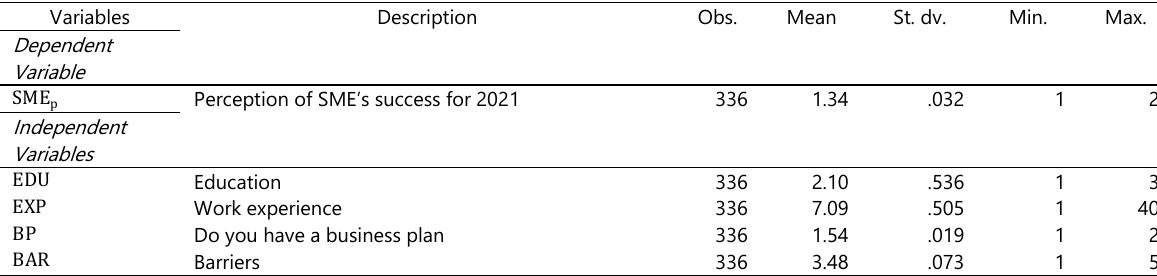
Table 1: Variable and Statistics Description (Source: Authors‟ calculation) Variables